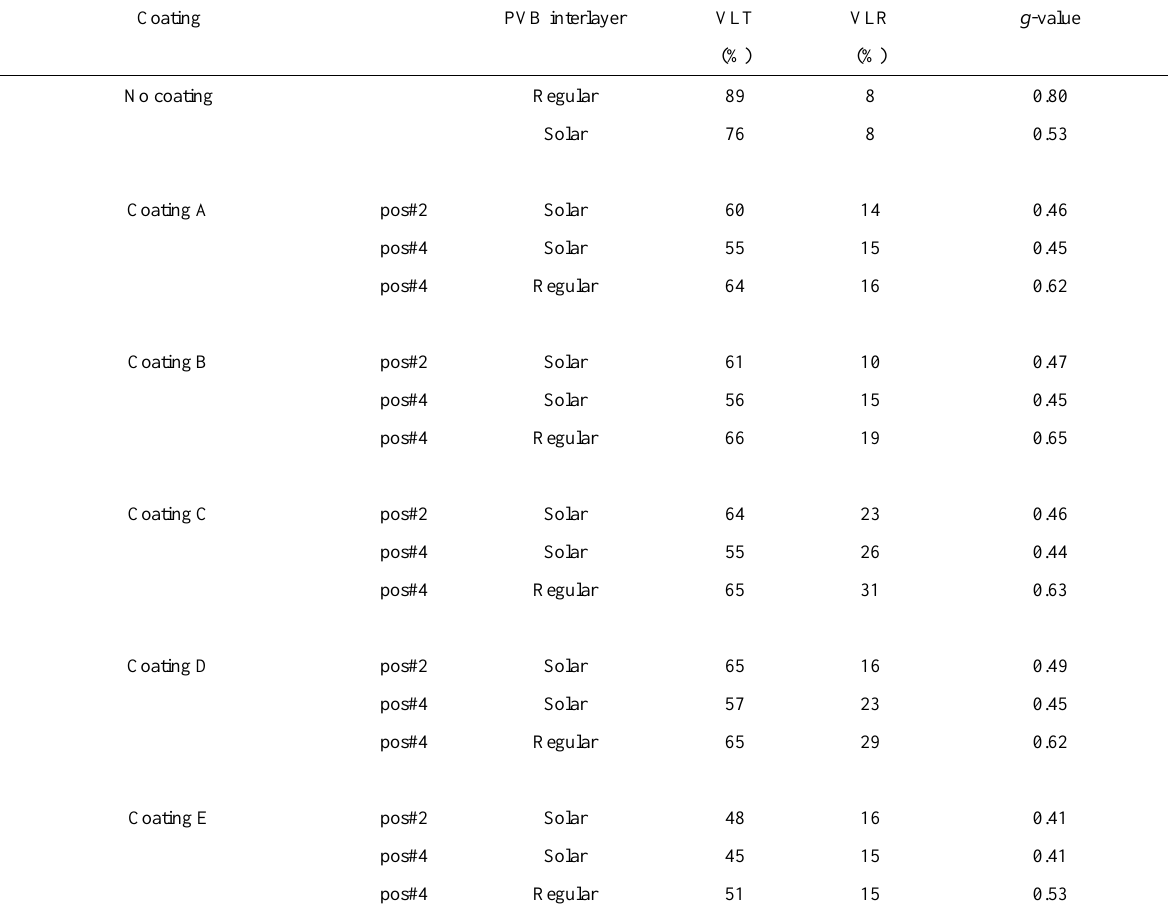
Table 3. Basic solar properties of robust coating/solar PVB